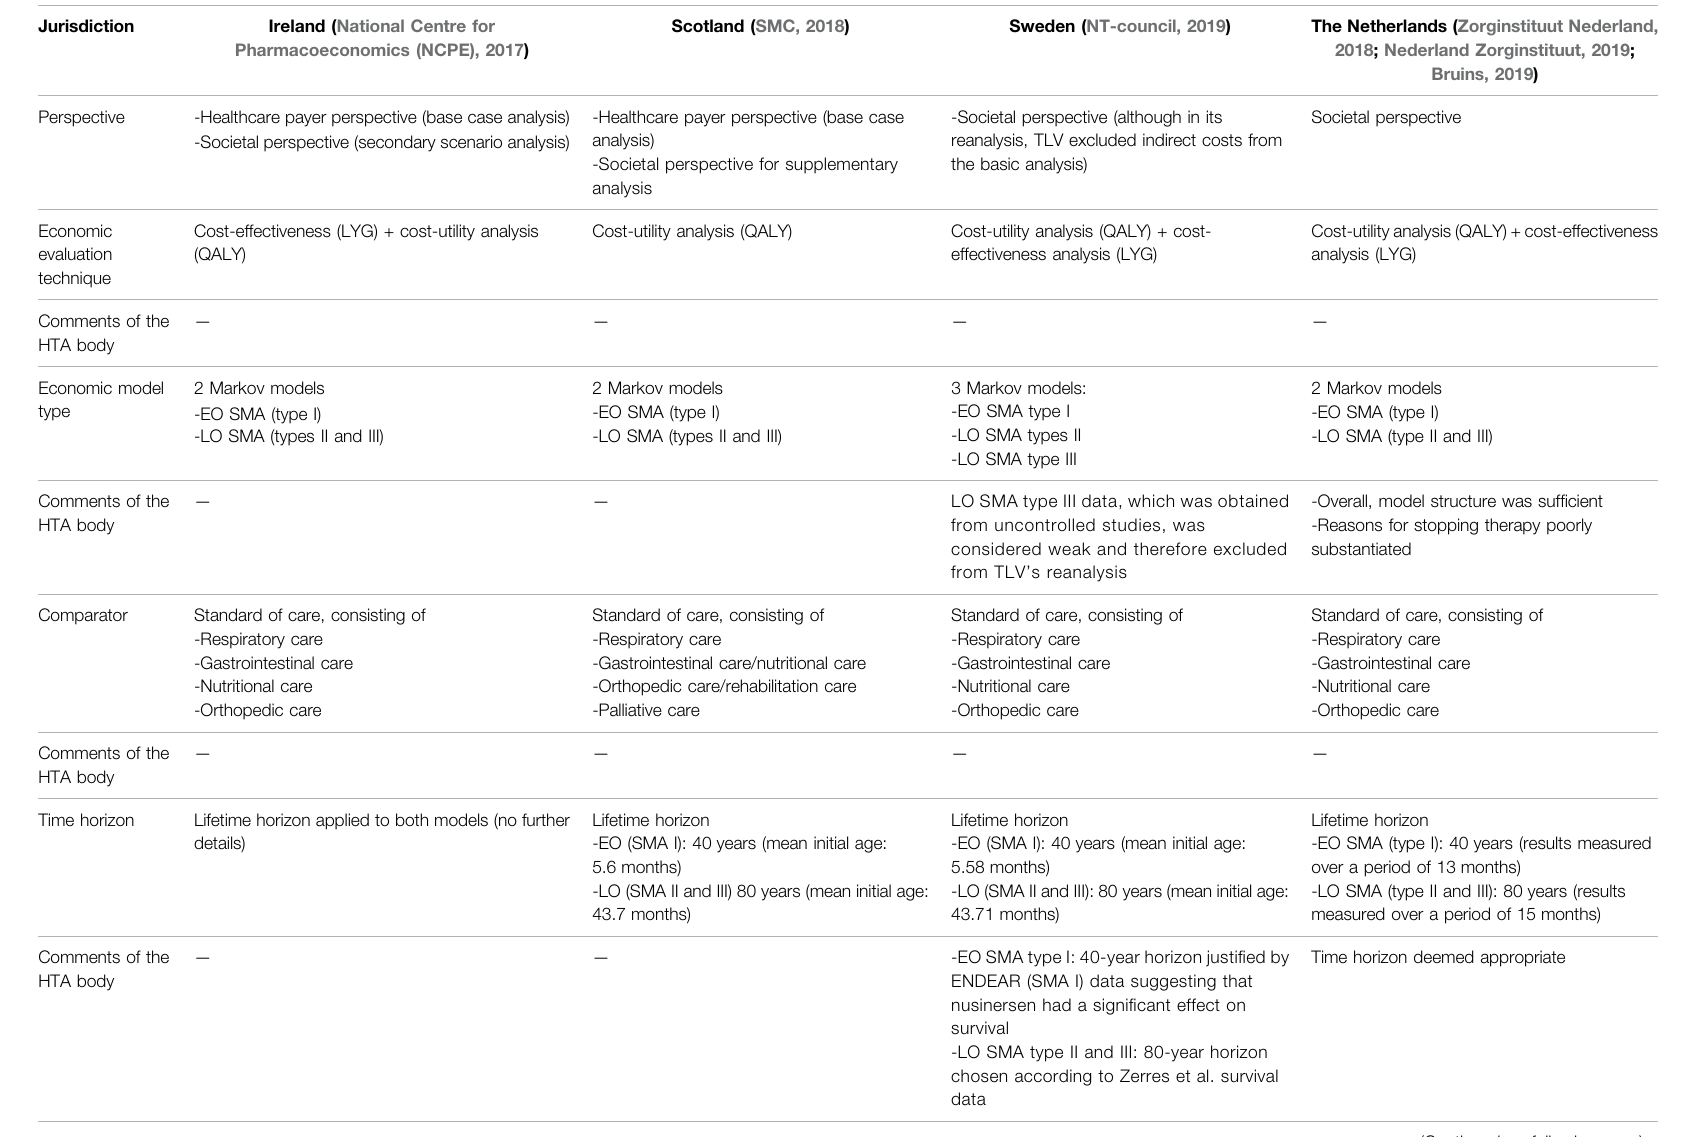
TABLE 2 | Overview of the design of the economic evaluation of nusinersen in six European countries, the US, and